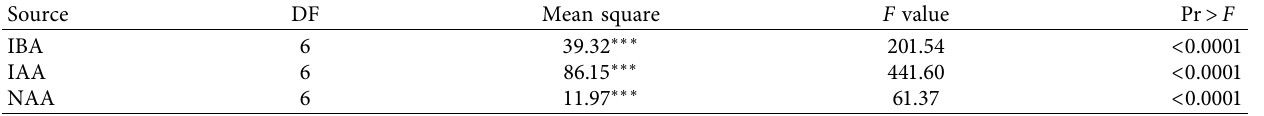
Table 9: ANOVA summary of effect of IBA, IAA, and NAA on in vitro rooting of A. corrorima . Source DF